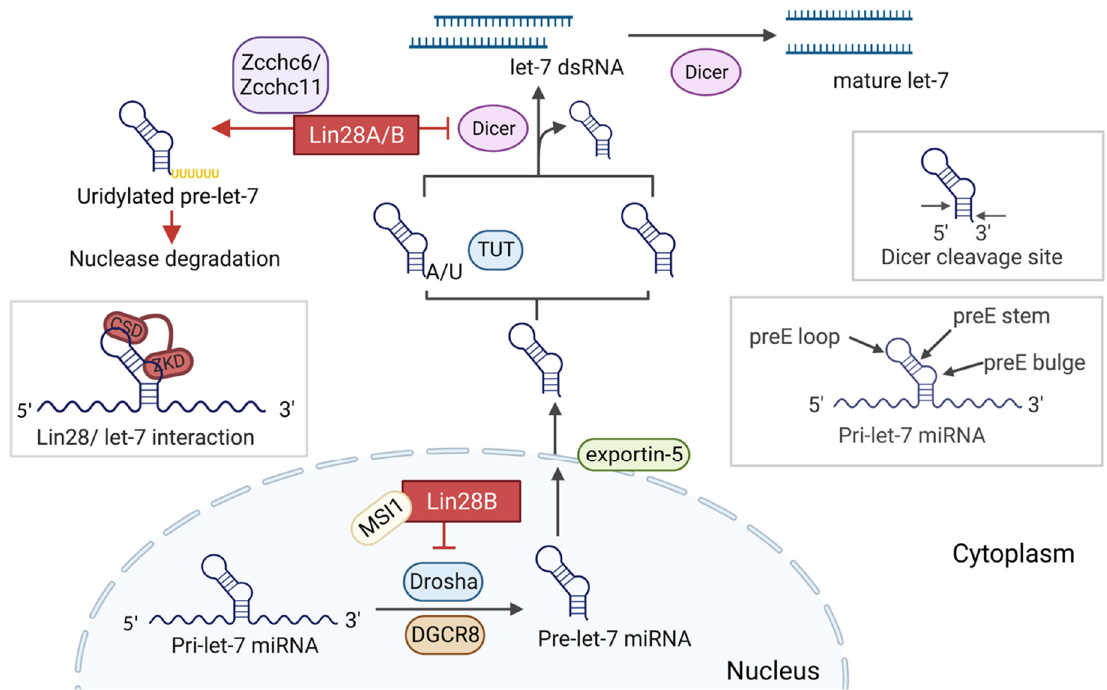
Figure 1. The biogenesis of let-7 microRNA. In the absence of Lin28B, pri-let-7s are cleaved into pre-let-7 miRNAs and then converted to mature let-7 with the aid of Dicer in both cytoplasm and nucleus. The stages at which Lin28A and/or B inhibit let-7 maturation are marked. The lower right square shows the structure of pri-let-7. The upper right square demonstrates the site where Dicer cleaves pre-let-7. The left square shows the bipartite binding of Lin28A/B to pri/pre-let-7 members. Created with BioRender.com.